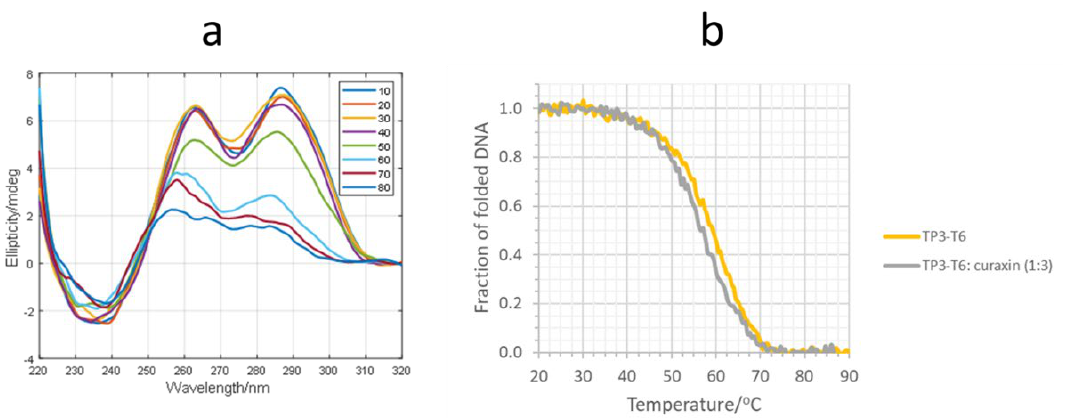
Figure 5. ( a ) Selected CD spectra recorded along the melting of the TP3-T6/curaxin 1:3 mixture. The whole data set is given in Supplementary Materials; ( b ) Fraction of folded DNA vs. temperature calculated from the melting of TP3-T6 and of the TP3-T6/curaxin 1:3 mixture at 265 nm. DNA and ligand concentration were 2 and 6 μM, respectively, 20 mM phosphate buffer (pH 7.1), 70 mM KCl.